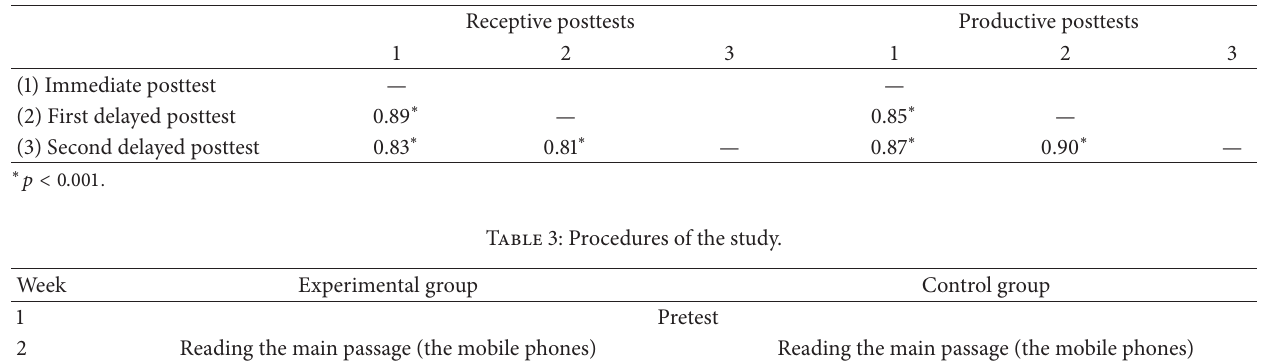
Table 2: Pearson correlation coefficients between the posttests.